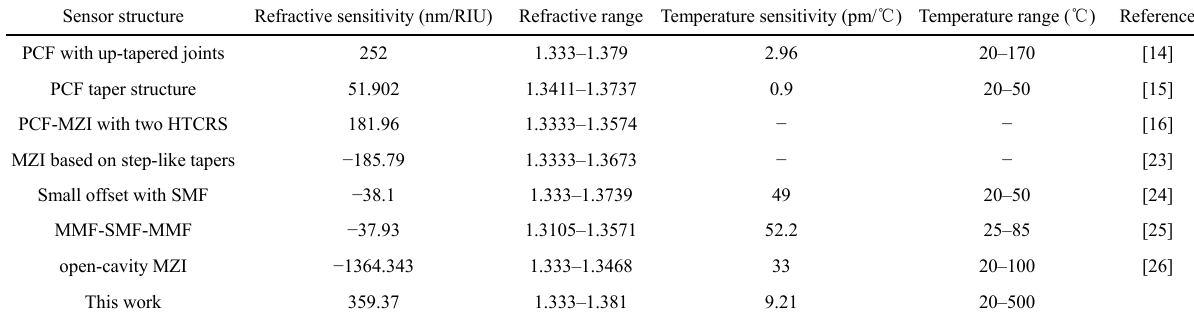
Table 1 Comparison between the available MZI sensors and the proposed